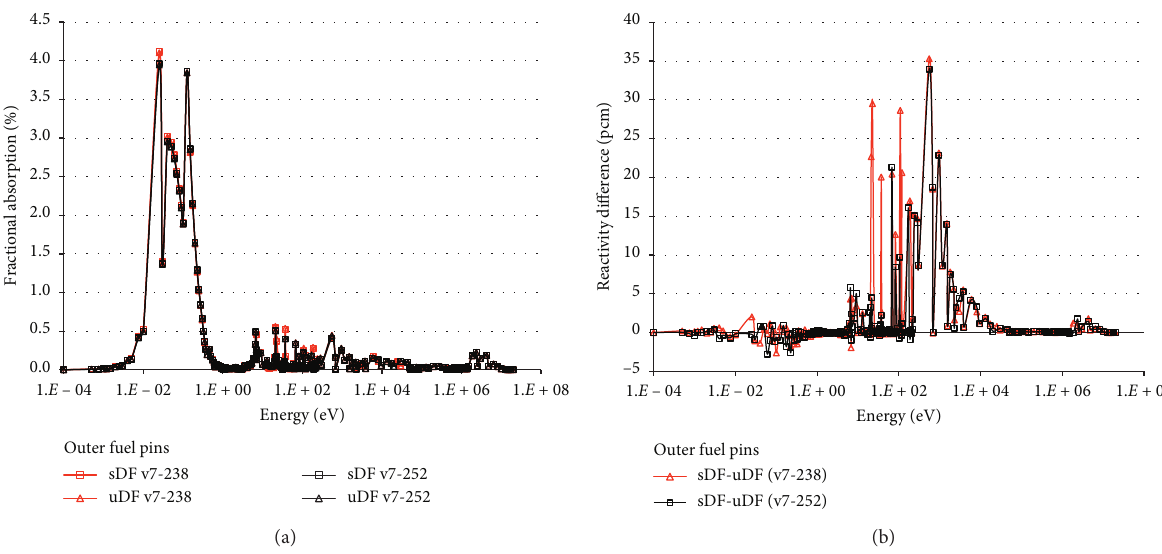
Figure 6: Distributions of fractional absorption (a) and Δ ρ